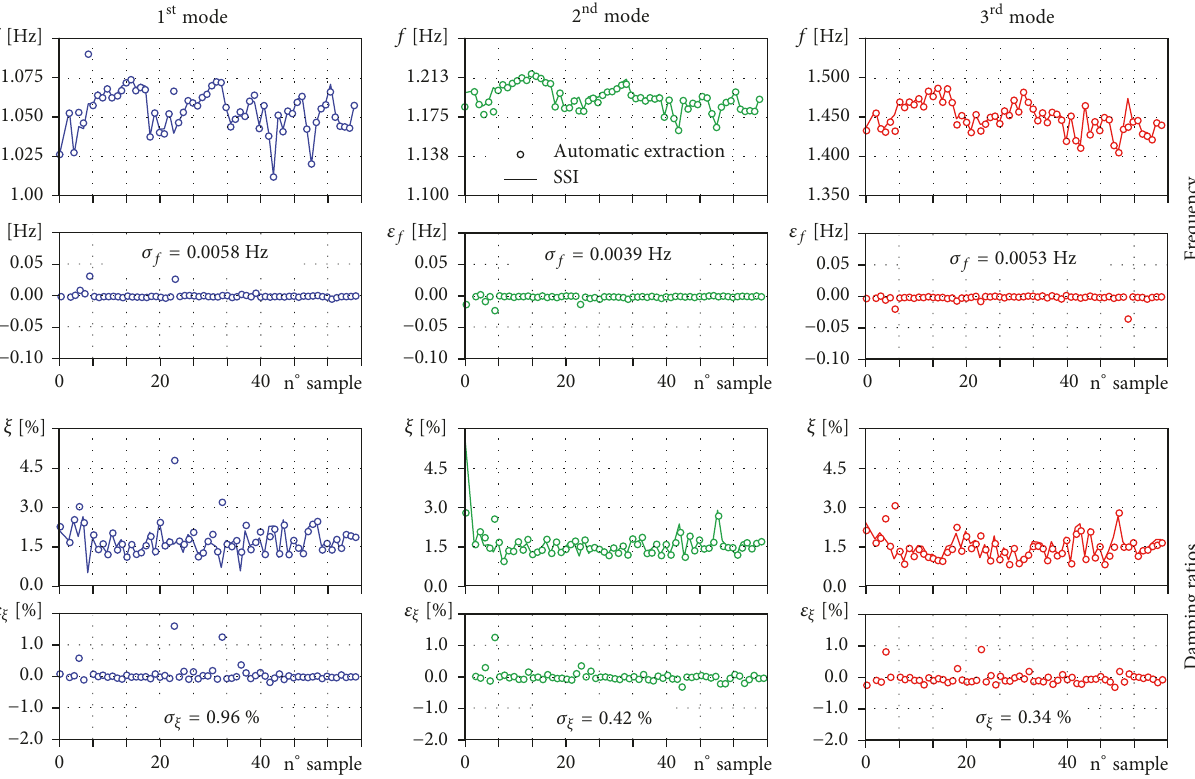
Figure 8: Comparison of modal parameters extracted from the automated procedure and from the SSI approach; (b) errors of the developed